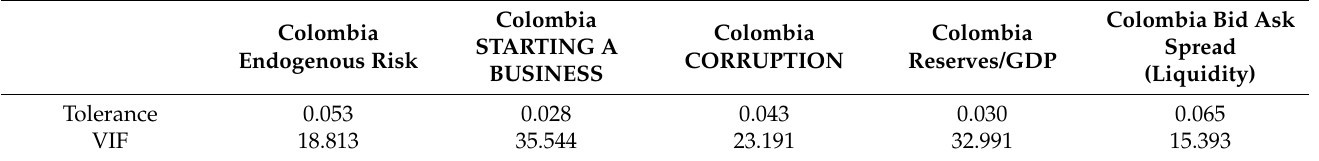
Table 7. VIF Multicollinearity test for Colombia. Eliminated